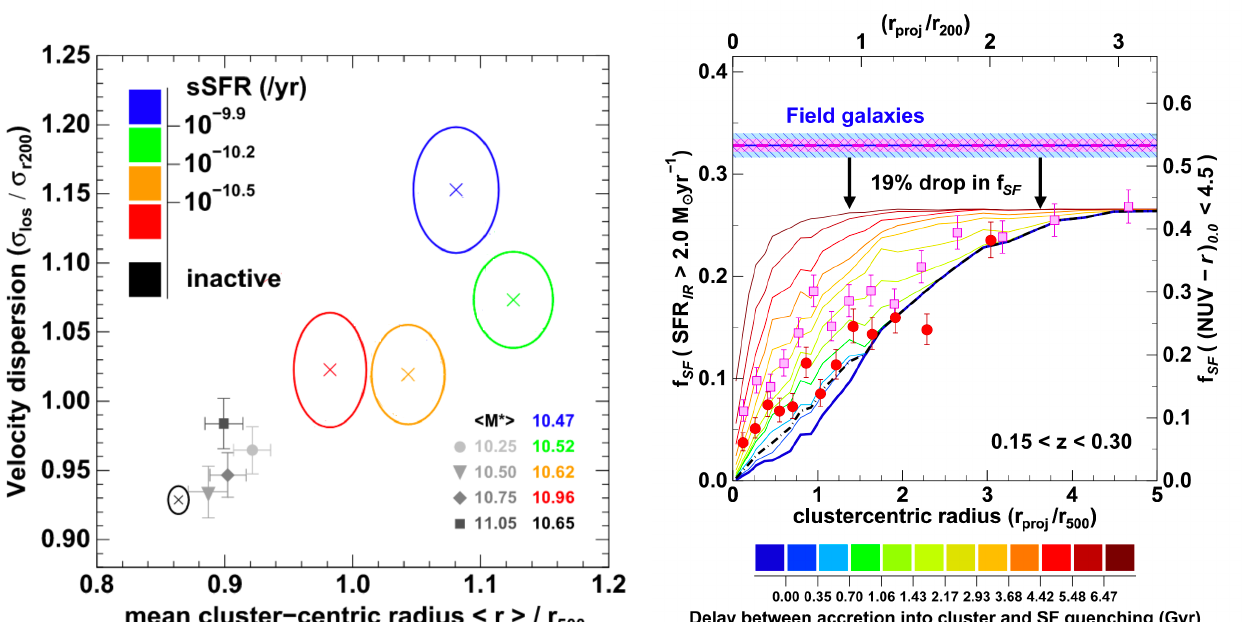
Figure 8. ( left ) Phase space (caustic) diagram of SFGs in the LoCuSS sample split into four bins of SSFR. X’s indicate the mean radii and line-of-sight velocity dispersions in each bin, with the ellipses showing the 1 σ uncertainties. Gray points are QGs. SFGs with suppressed SSFRs are kinematically separated from those without. ( right ) The star-forming fraction from obscured (red) and unobscured (pink) SF tracers. A sharp decrease is seen into the cluster cores. Delayed then rapid models of quenching are shown in the solid lines; a delay time of ∼ 1 Gyr best models the IR f SF . A ∼ 20% suppression below the field to large radii requires pre-processing to reproduce. The dot dash line indicates the model where all star formation is instantaneously quenched when galaxies reach pericenter. Figures adapted from Figures 8 and 16 in Haines et al. [421], reproduced by permission of the